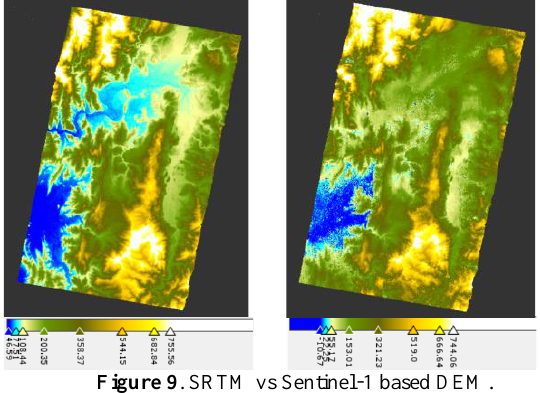
Figure 9 . SRTM vs Sentinel-1 based DEM.